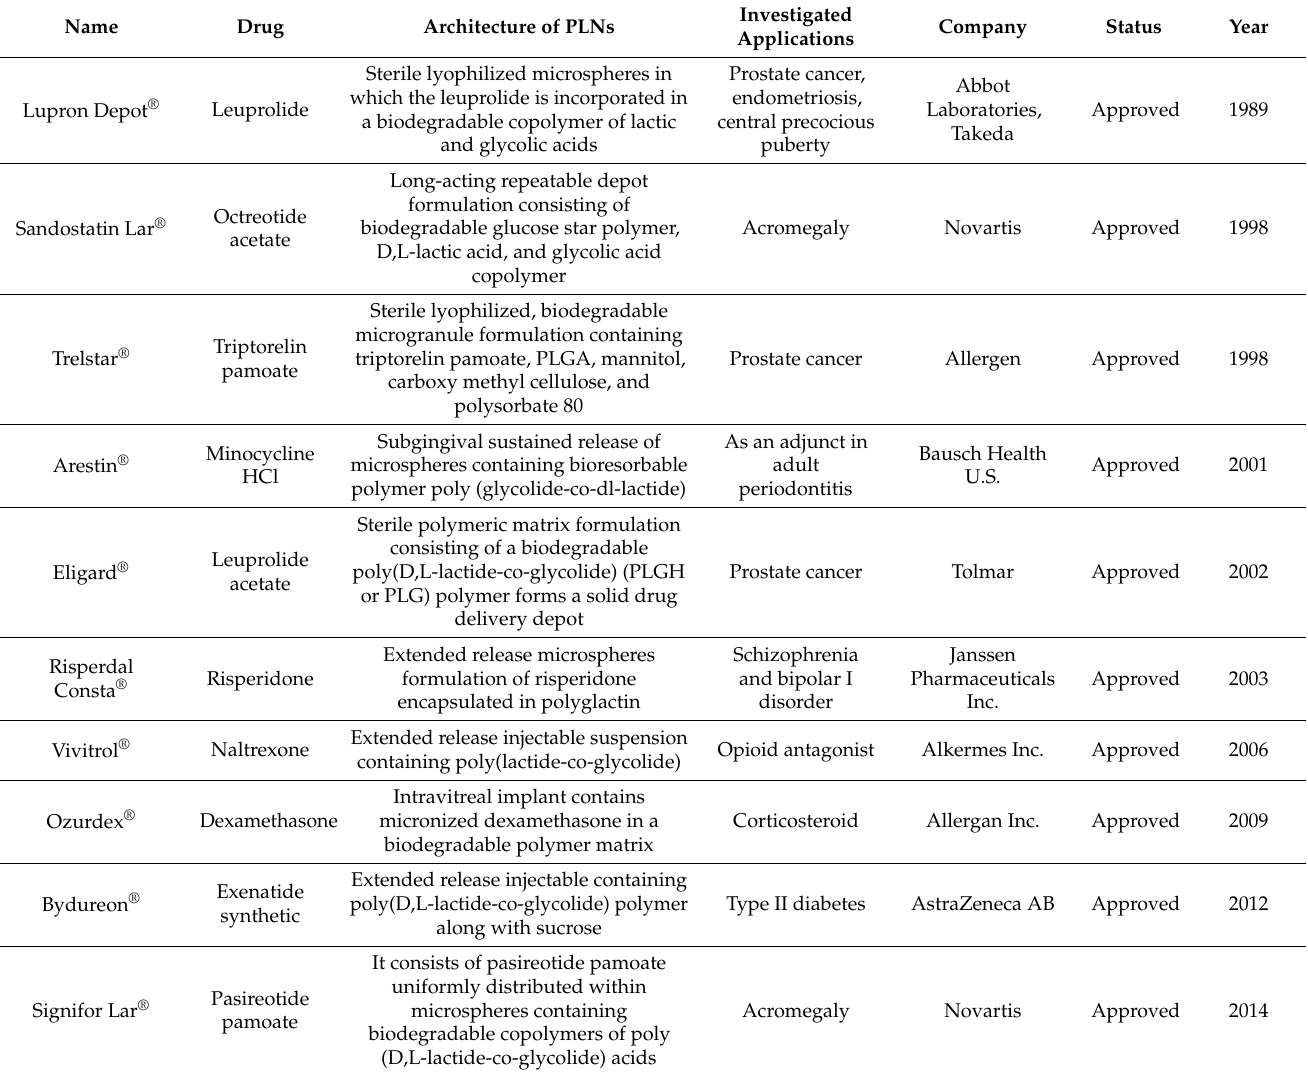
Table 5. Status of clinical trials of PLGA-based nanoparticles